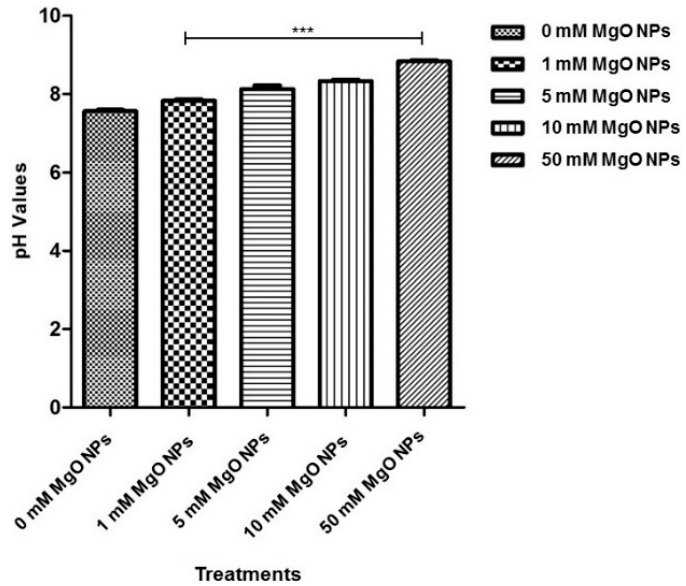
Figure 6. Analysis of the change in pH in hFOB 1.19 cells in response to the different concentrations of MgO NPs. Data are obtained as means ± SEM, n = 3; *** p -value ≤ 0.0001 when compared to the control group.